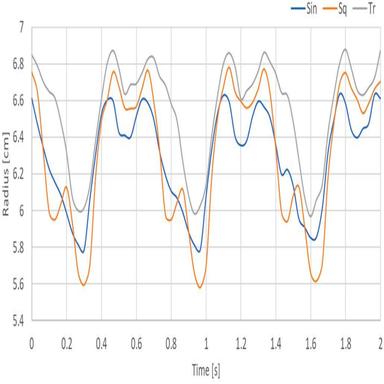
Radius data under 10 psi, 1.5 Hz, and unload condition.